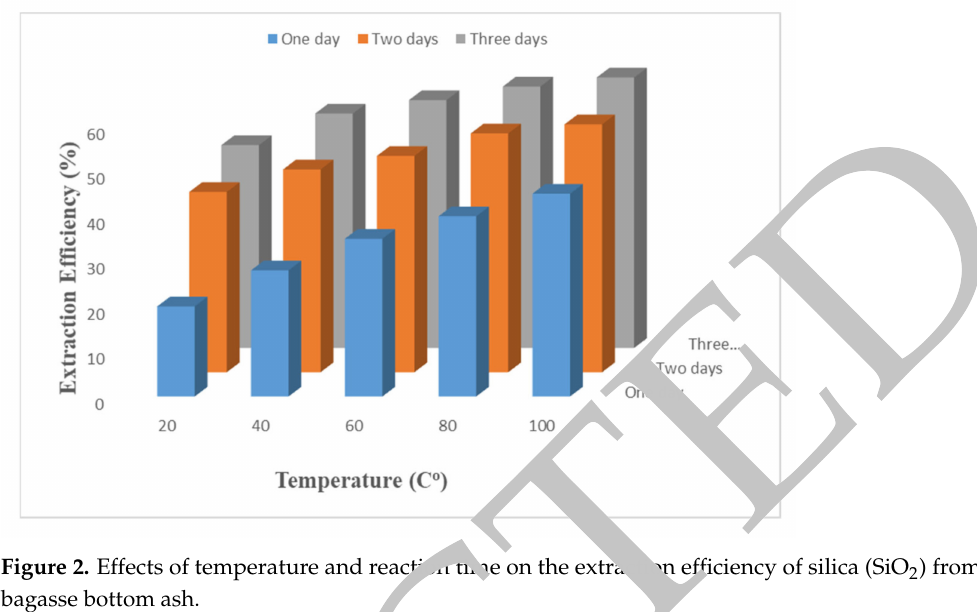
Figure 2. Effects of temperature and reaction time on the extraction efficiency of silica (SiO 2 ) from bagasse bottom